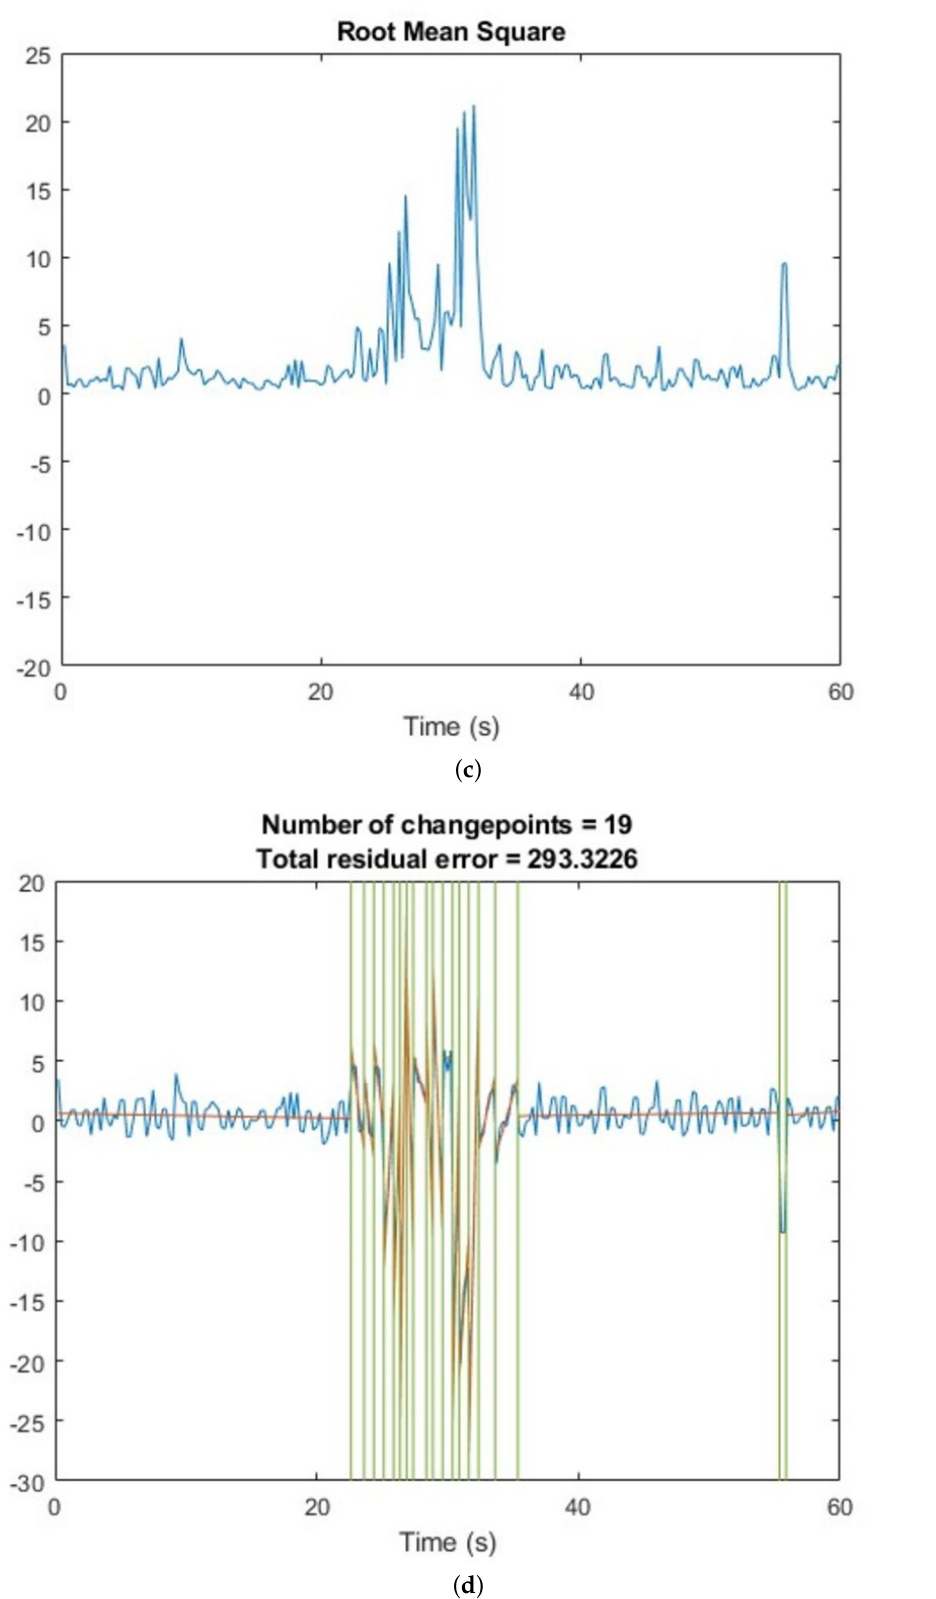
Figure 4. Parameter setting results for a human presence detection: ( a ) mean representation; ( b ) STD representation; ( c ) RMS representation; ( d ) number of changes in the